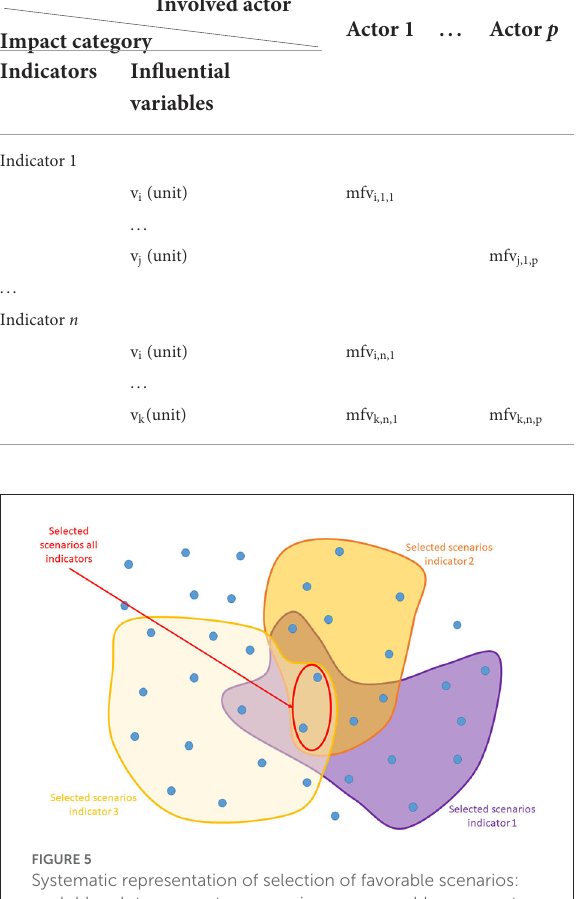
If discrete choices also imply thresholds or incompatibilities, some scenarios can be eliminated as schemed in Figure